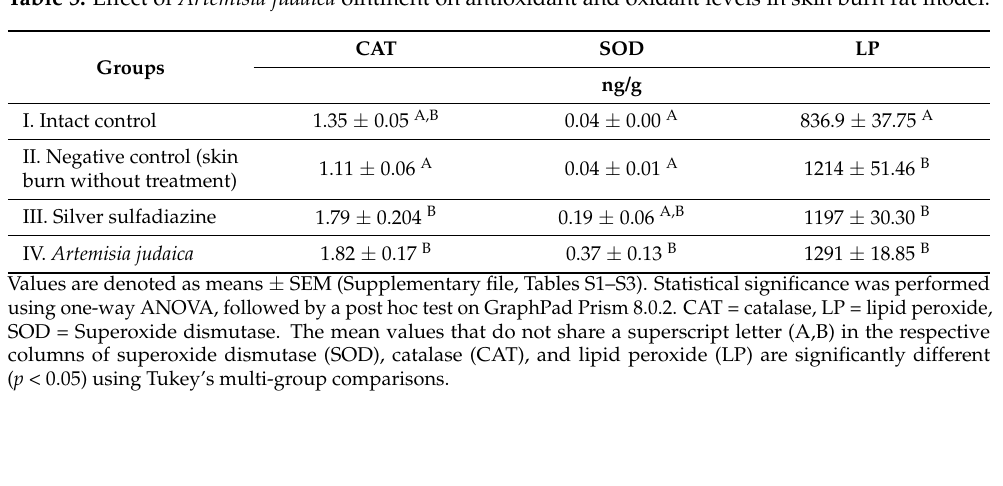
Table 5. Effect of Artemisia judaica ointment on antioxidant and oxidant levels in skin burn rat